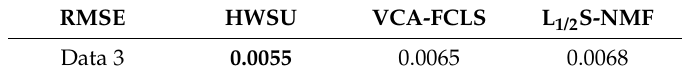
Table 7. The RMSE of unmixing results using HWSU, VCA-FCLS, MVC-NMF, L 1/2